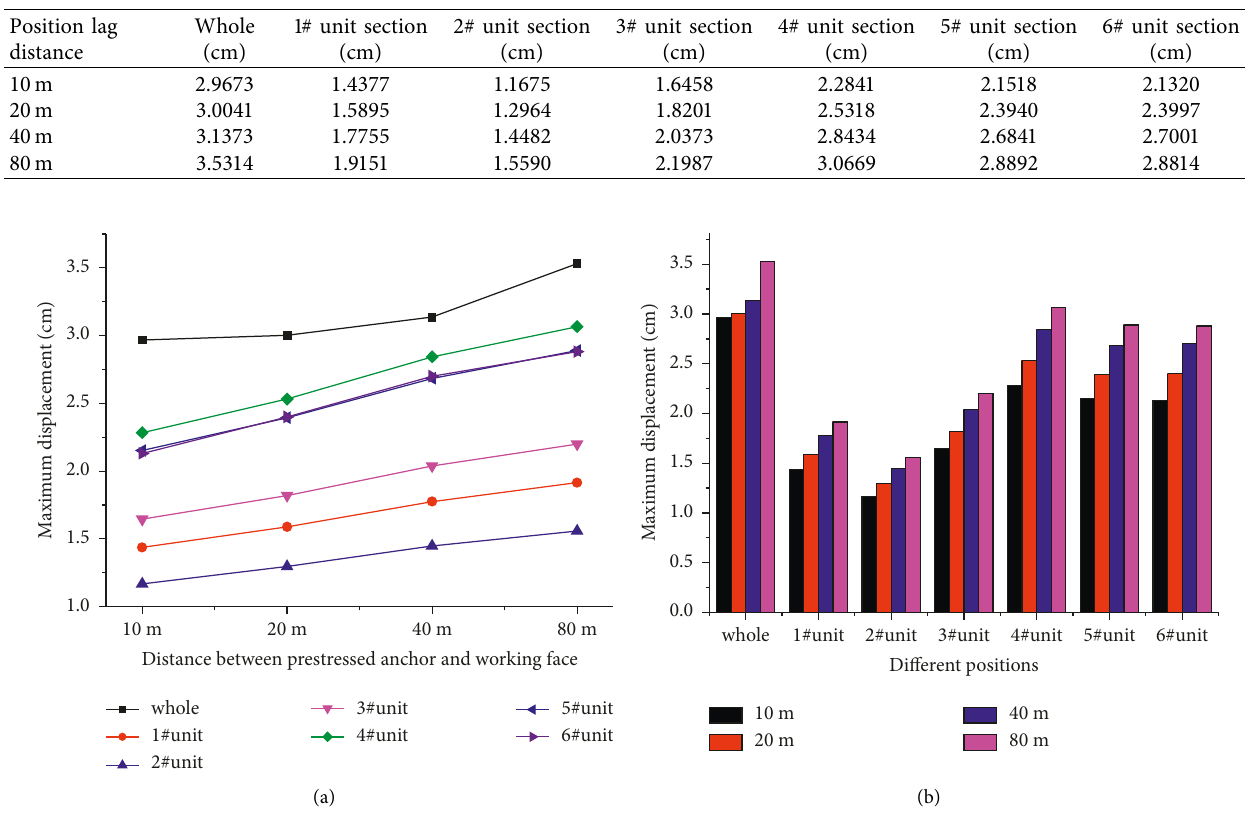
(a) Figure 16: Maximum displacement under different support time. (a) Diagram of curves. (b)